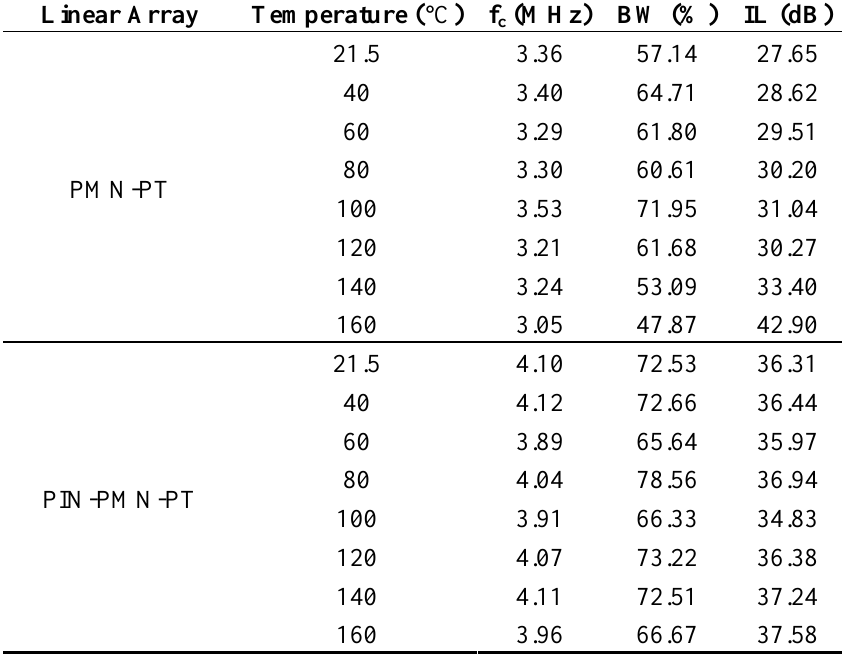
Table 6. Temperature dependence of the PMN-PT and PIN-PMN-PT linear array performance